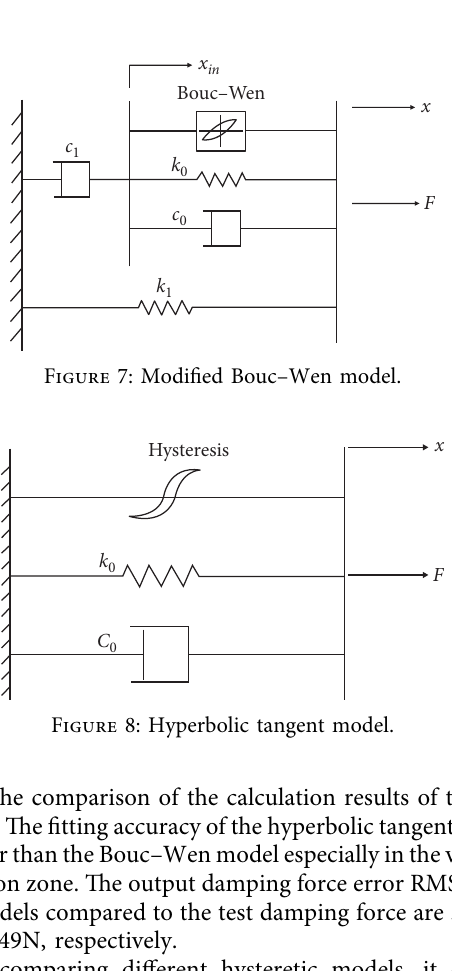
Figure 5: Mechanical properties of different amplitudes, current � 0.8 A, and frequency � 2 Hz. (a) Damper force-displacement. (b) Damper force-velocity.